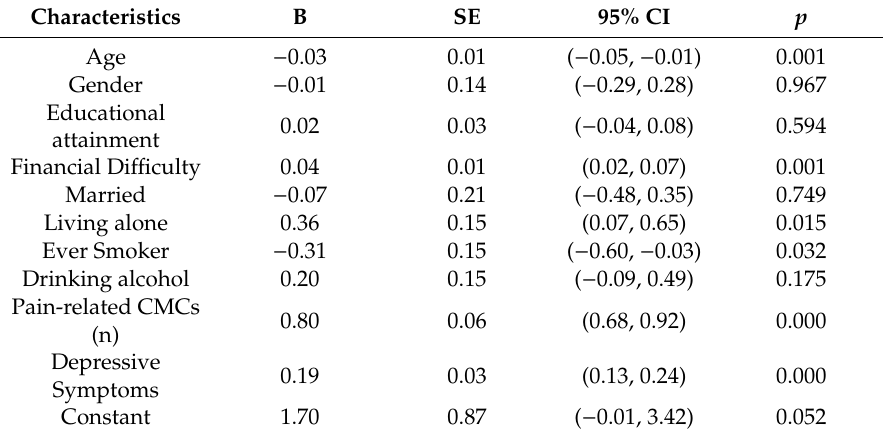
Table 3. Multivariable model of determinants of pain intensity in a sample of economically disadvantaged AA older adults in South Los